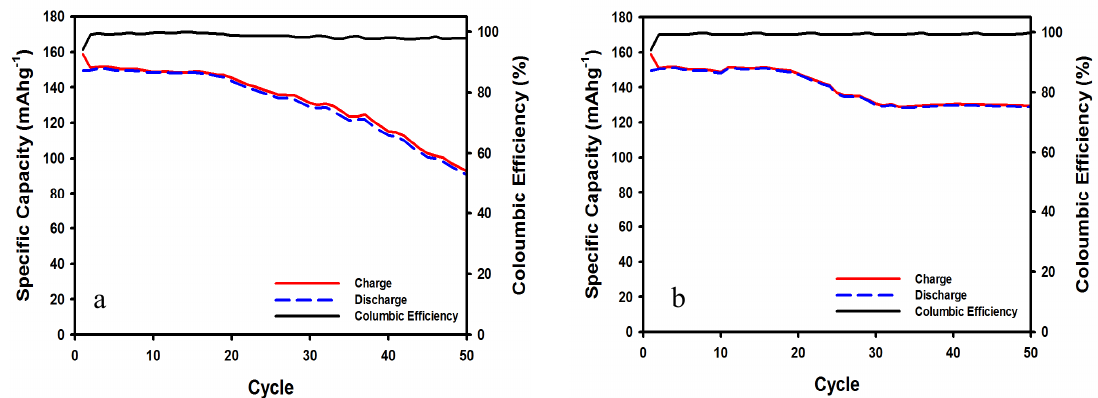
Figure 7. Cycling performance and coulombic e ffi ciency of LiCoO 2 commercial cathode at 60 ◦ C in ( a ) 1 M LiTFSI in 60% EMI-TFSI 40% EC / DMC (1:1 v / v ) electrolyte, and ( b ) 1 M LiTFSI in 60% EMI-TFSI 40% EC / DMC (1:1 v / v ) with 5 wt% SN. Current density = 100 mA g − 1